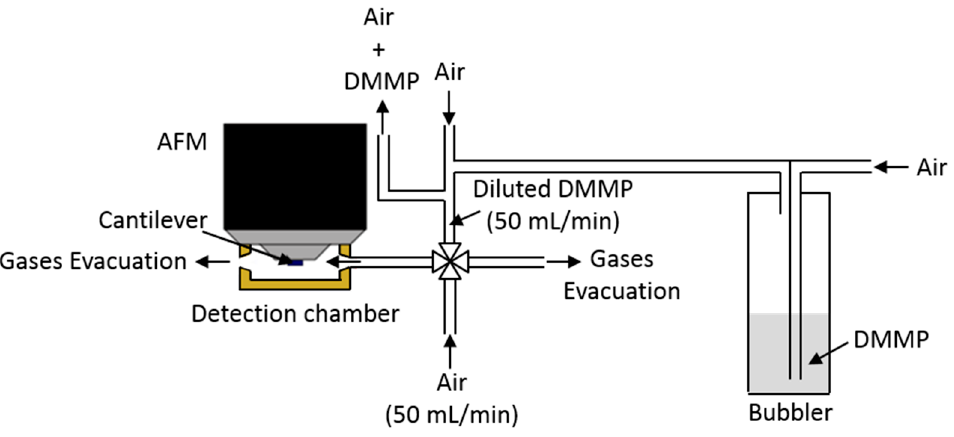
Figure 1. Scheme of the detection system.